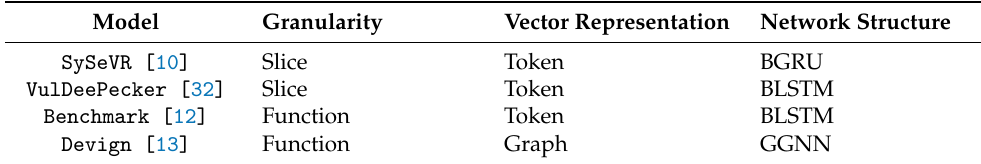
Table 7. Summary of target DL-based vulnerability detection